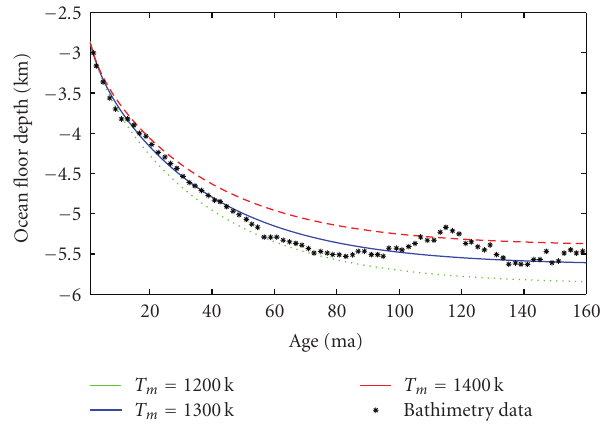
Figure 10: Results of numerical simulations illustrating the response of VBA model results to change in the value assumed for the basal temperatures ( T i ). The square symbols indicate mean oceanic bathymetry